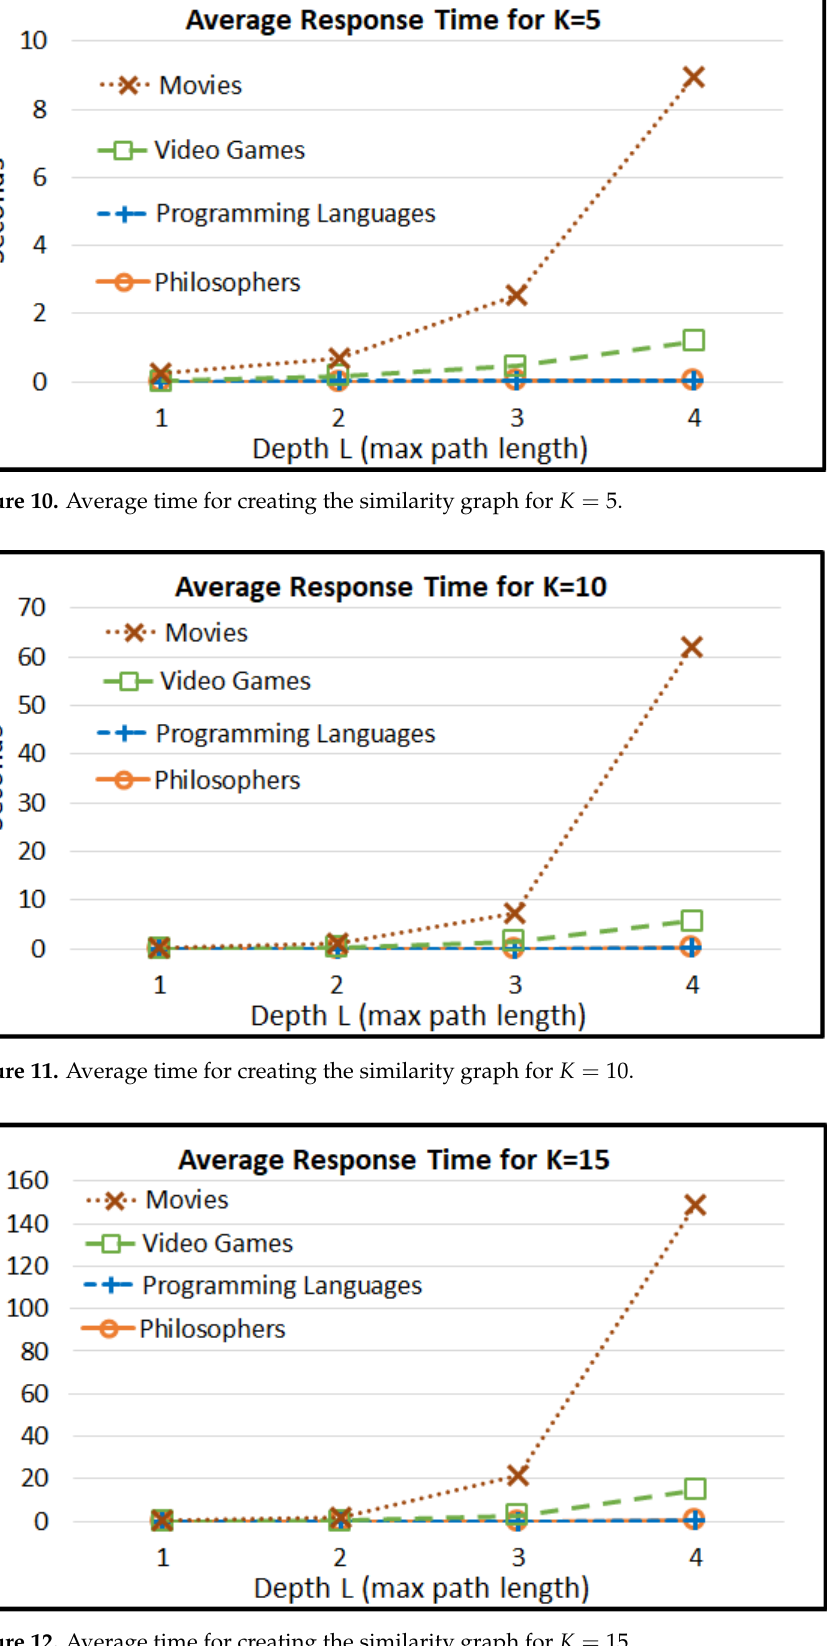
Figure 12. Average time for creating the similarity graph for K =